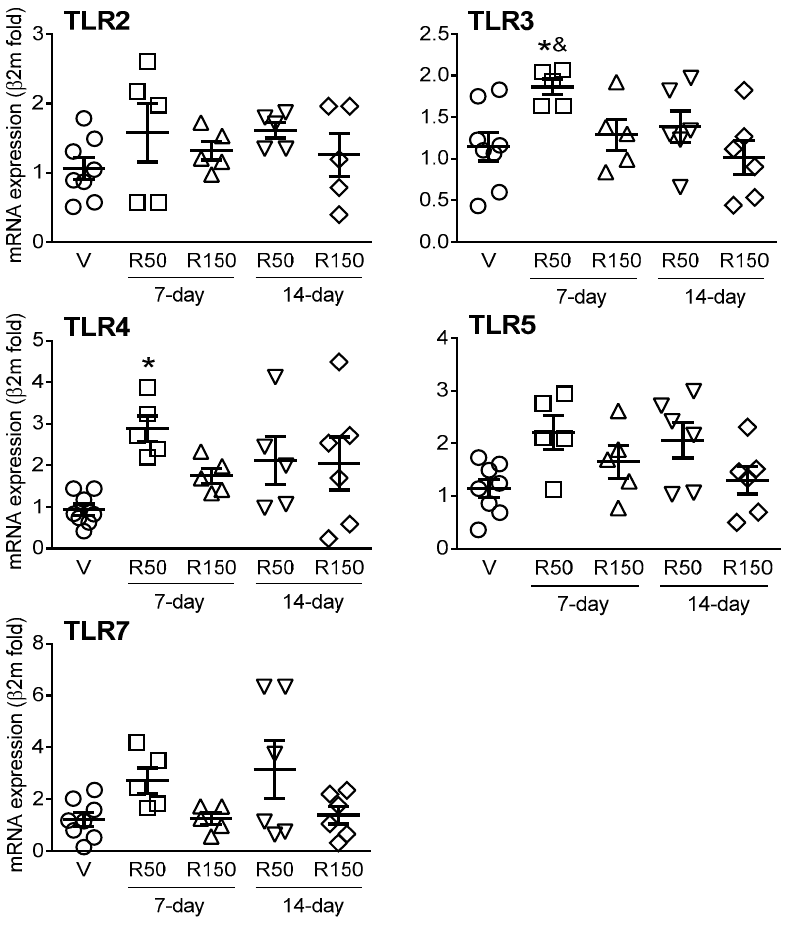
Figure 7. Effects of rifaximin on the colonic expression of TLRs. Each point represents an individual animal; the horizontal lines with errors correspond to the mean ± SEM. For the sake of clarity, and since no differences were observed among them, vehicle-treated animals have been merged in a single group ( n = 8). *: p < 0.05 vs. V; &: p < 0.05 vs. R150 14-day. V: Vehicle; R50: rifaximin at 50 mg/kg; R150: rifaximin at 150 mg/kg.